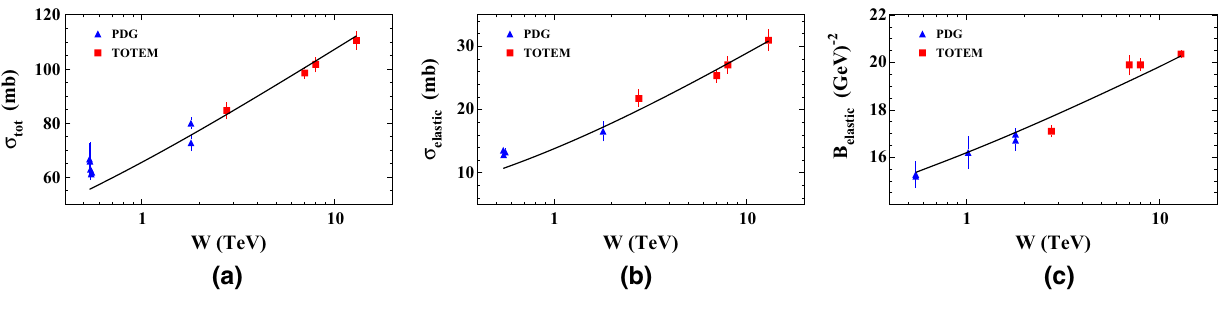
Fig. 2 The energy behaviour of σ tot ,σ el and the slope B el for proton-proton scattering as predicted in our model. Data are taken from Refs. [50–52]. The data taken for the fit were for W ≥ 1 TeV